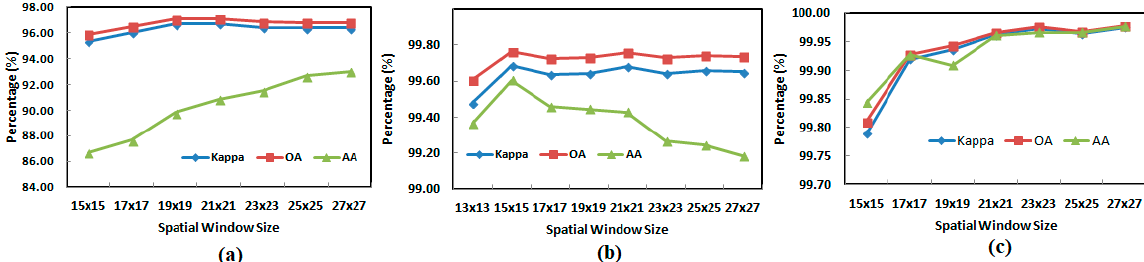
Figure 4. The effect of the spatial window size on the performance (in percentage) of the GGBN model over the ( a ) IP, ( b ) UP, and ( c ) SA datasets.